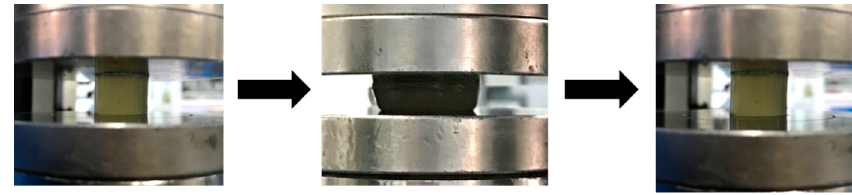
Figure 7. Digital photos of CMC-OSA-DTP hydrogels before and after compressive loading.